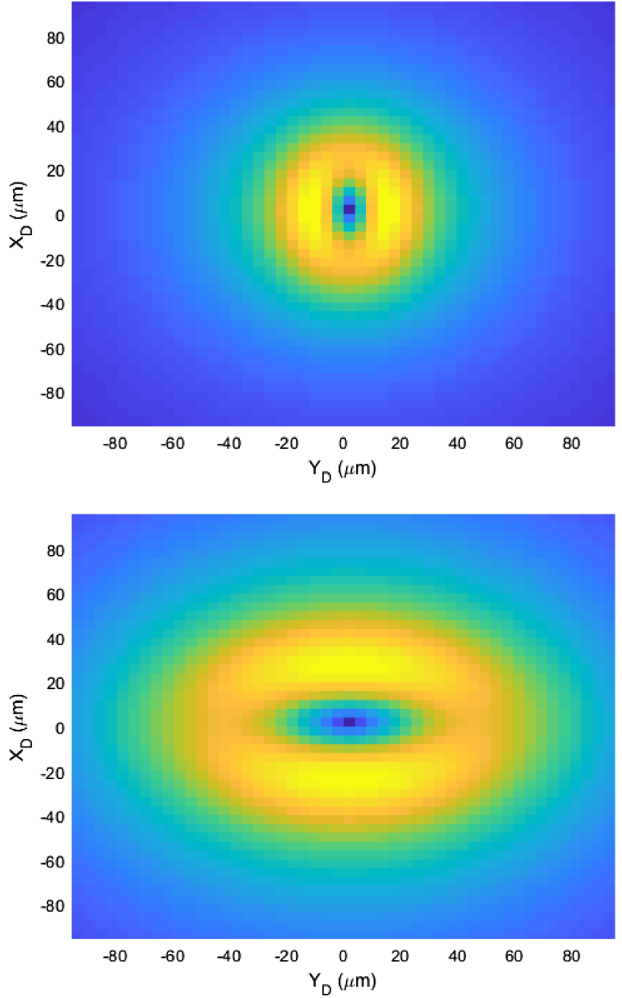
FIG. 13. 2-dimensional asymmetric COTR distributions, cal- culated for γ ¼ 1000 and λ ¼ 0 . 5 μ m. Top: beam sizes of Σ